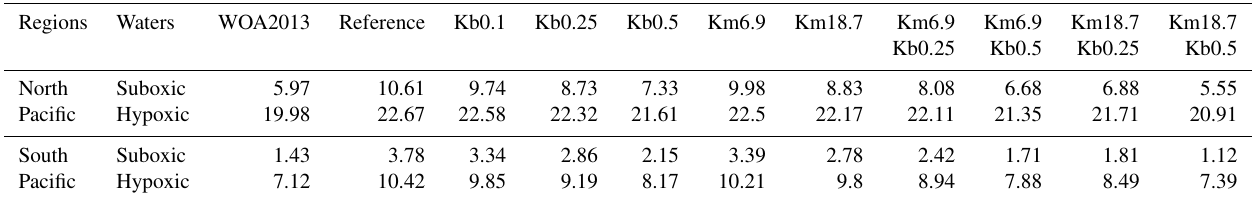
Table 2. Volumes (10 15 m 3 ) of suboxic and hypoxic waters from WOA2013 and model simulations. Regions